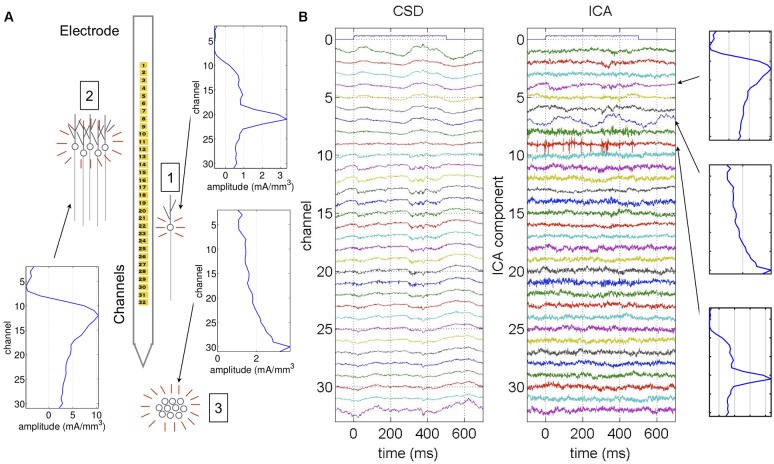
Example of ICA applied to neural data. Data generated from a single anesthetized experiment used as an example throughout this study. (A) Different populations generate field potentials across the electrode, resulting in overlapping signals recorded at each channel. For example, the signal from a single cell (1) may have the highest amplitude in a single channel, while other channels have much lower amplitude. The signal from a larger population (2) may have high amplitude across multiple channels with a single dipole. A population below the electrode (3) may generate the highest amplitude signal in the channel closest to the population, which decays with channels further from the population and doesn’t display a dipole (Herreras et al., 2015). (B) Example CSD from 32-channel electrode along with ICA decomposition. The ICA components are listed in order from largest to smallest amplitude over the entire experiment. In the CSD, the auxiliary channel 0 indicates a tone is played at time 0, and we see an immediate reaction to the stimulus in channels 11 through 17. This immediate reaction to the tone is summarized in ICA component 4. Each ICA component is associated with an anatomical map showing the amplitude of that component across the electrode. The anatomical map for ICA component 4 is consistent with the large population (2) in (A). Similarly, high frequency activity seen in the CSD in channels 20 and 21 is reflected in ICA component 9, whose anatomical map is consistent with the single cell (1) in (A). Finally, there is a 4 Hz sinusoidal oscillation in ICA component 7 that is not apparent in the original CSD. The anatomical map gradually increases toward the lowest channel and there is no dipole, indicating that the oscillation was generated from below the electrode as in population (3) in (A).